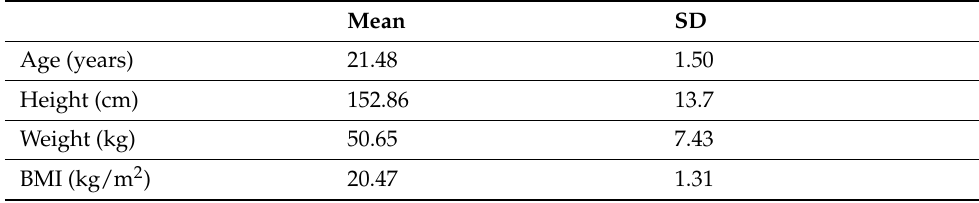
Table 1. Baseline data of subjects ( n =